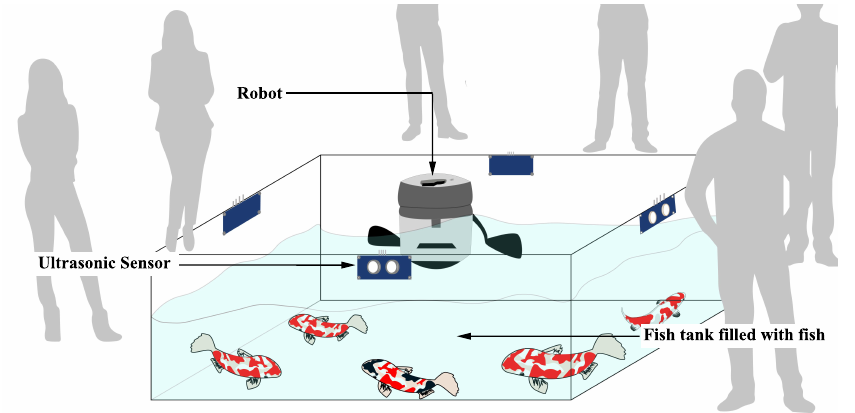
Figure 4. An illustration of the experimental setup used in the research, which includes ultrasonic sensors for detecting human presence.